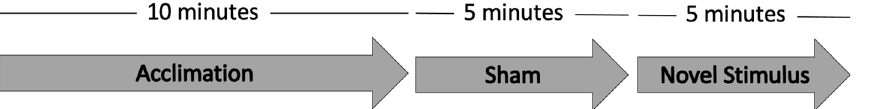
Figure 2. Testing timeline. The novel stimulus presented was a 2.5 cm feather, 2.5 cm snake, entire feather, or entire snake depending on the test